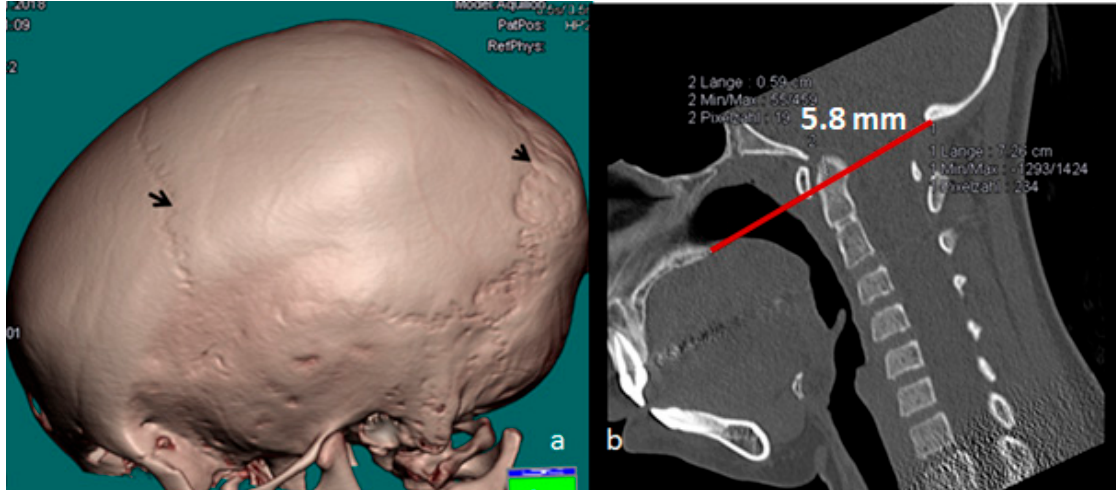
Figure 5. ( a , b ) Three-dimensional reconstruction CT scan of a 10-year-old girl with multicentric was organized to further understand the nature of these wormian bones. Three-dimensional reconstruction CT scan shows progressive separation of the lambdoid sutures, giving an overly stretched-pastry-like appearance (arrow head denotes progressive softening and melting of the sutures, in comparison to the normal coronal suture-arrow) ( a ) Sagittal 3DCT of the craniocervical junction shows Chamberlain line (which joins the hard palate to the posterior lip of the foramen magnum). The odontoid process length is greater than 5.8 mm. The overall picture is of dolicho-odontoid with posterior inclination ( b ) * Chamberlain line: a line connecting the back of the hard palate with the opisthion. Seen on a lateral view of the craniocervical junction via conventional radiograph, but with much better visualization and localization via 3D sagittal CT scan of the craniocervical junction has been applied. The importance lies in diagnosing basilar impression or invagination, particularly when the tip of the dens is more than 3 mm above the line.